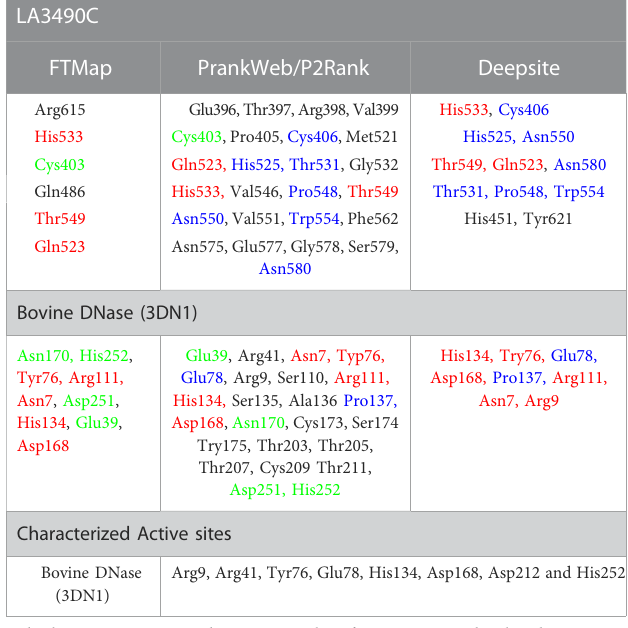
Red color represent amino acids common resultant from FTMap, PrankWeb and Deepsite. Blue color represent amino acids common resultant from PrankWeb and Deepsite. Green represent amino acids common resultant from FTMap, and